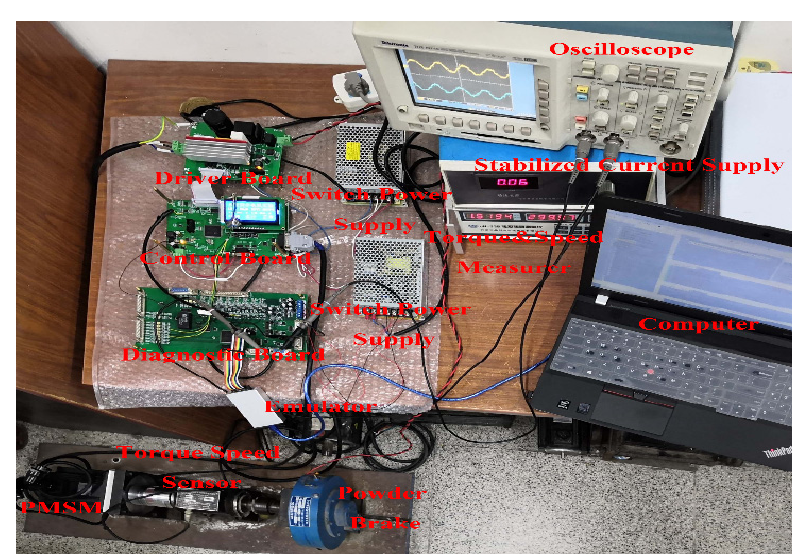
Figure 13. Photograph of the experimental setup.